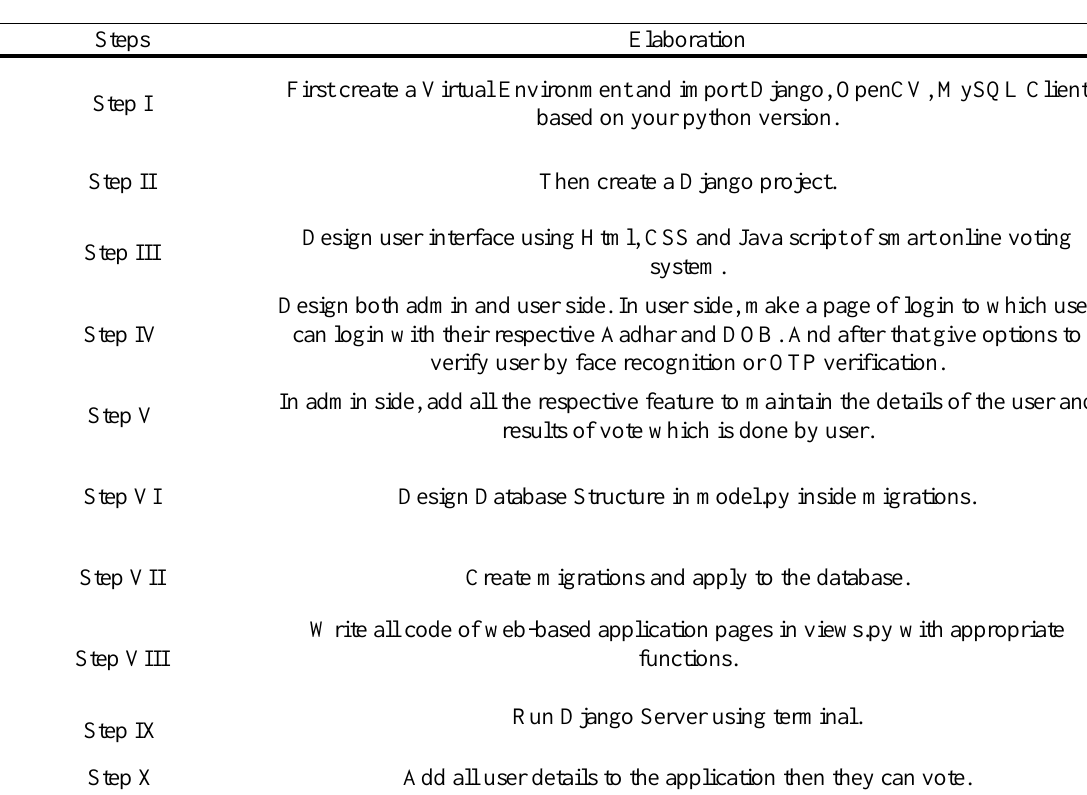
Table 3. Pseudo code for smart voting web-based